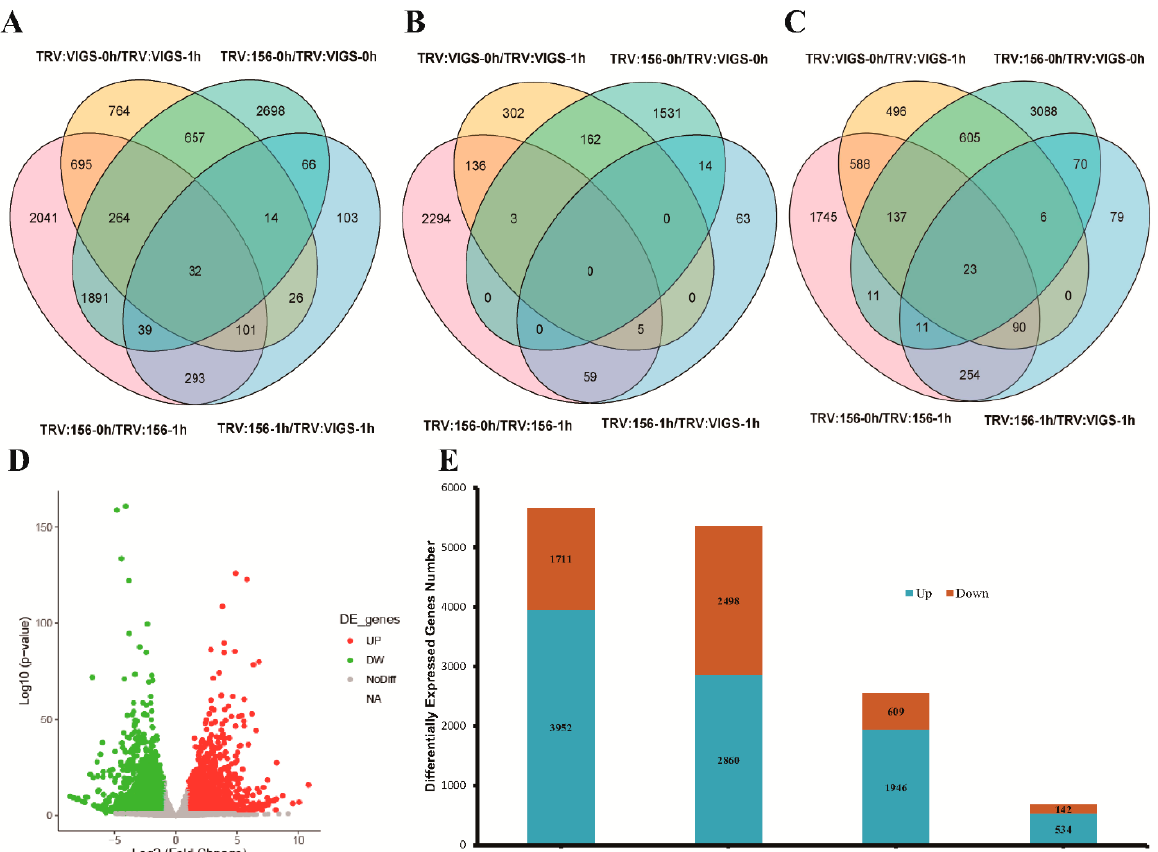
Figure 6. Details of RNA-seq data differentially expressed genes (DEGs) in four comparison sets. ( A ) Venn diagram showing overlapping of total DEGs among four comparison sets. ( B ) Overlapping of downregulated genes. ( C ) Overlapping of upregulated genes. ( D ) Volcano plot, identification of DEGs by Log2FC and q-value (FDR) ≤ 0.05. ( E ) Bar graph representing four combinations; total, blue color representing up, Red-accent2 color denoting downregulated DEGs in each combination group.